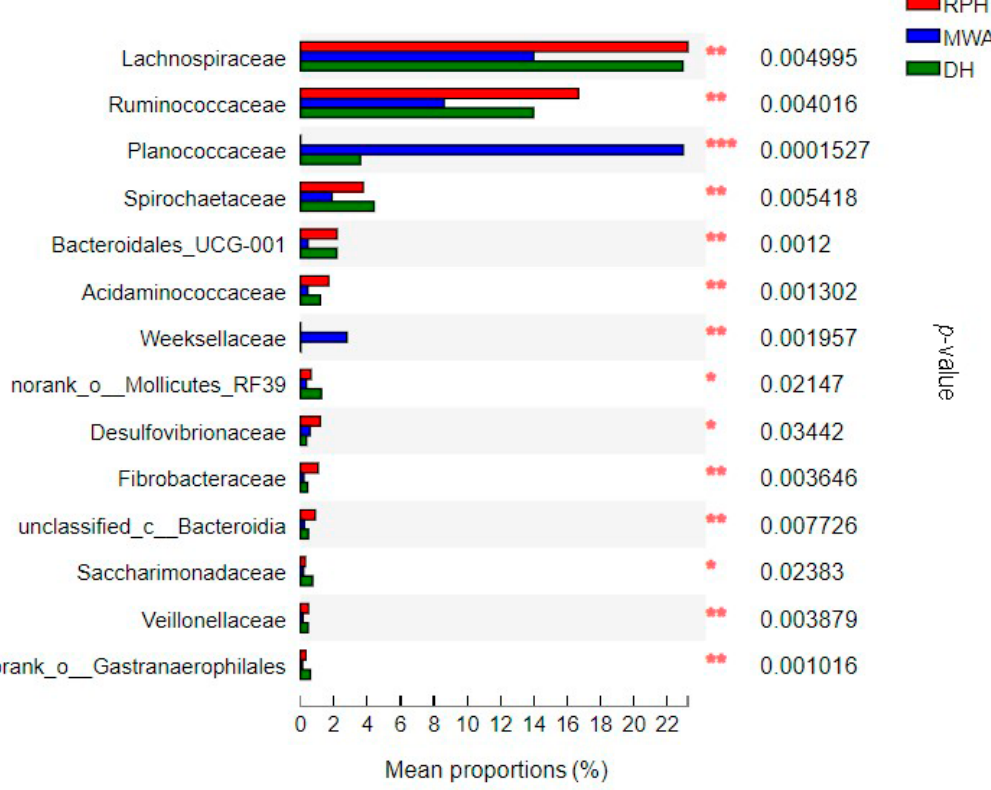
Figure 11. The bar plot shows the bacterial family with significant differences among the CPH and